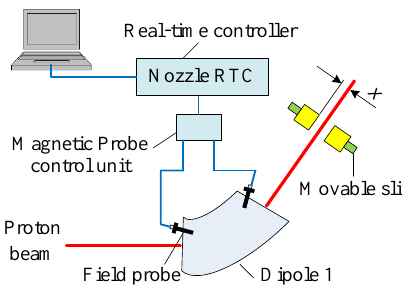
Figure 9. Schematic of the energy verification system for the nozzle in SC200.